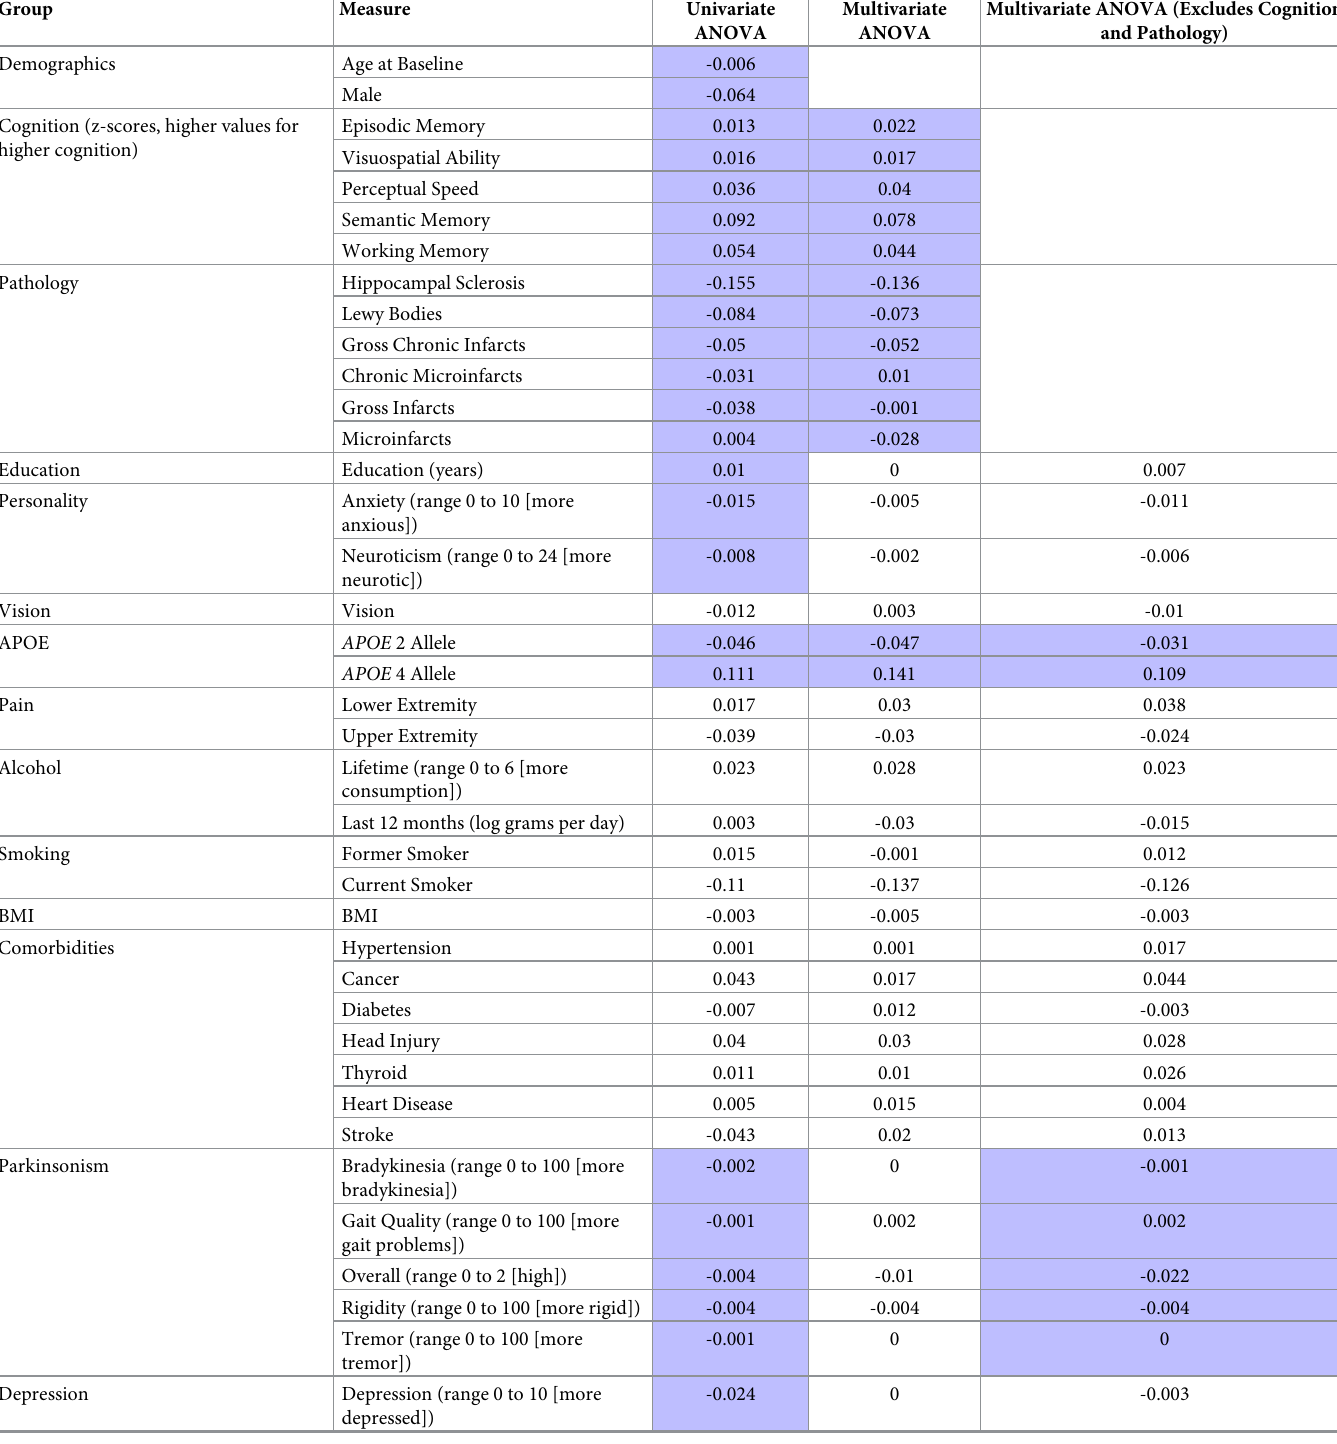
Table 4. Coefficients from the baseline ANOVA